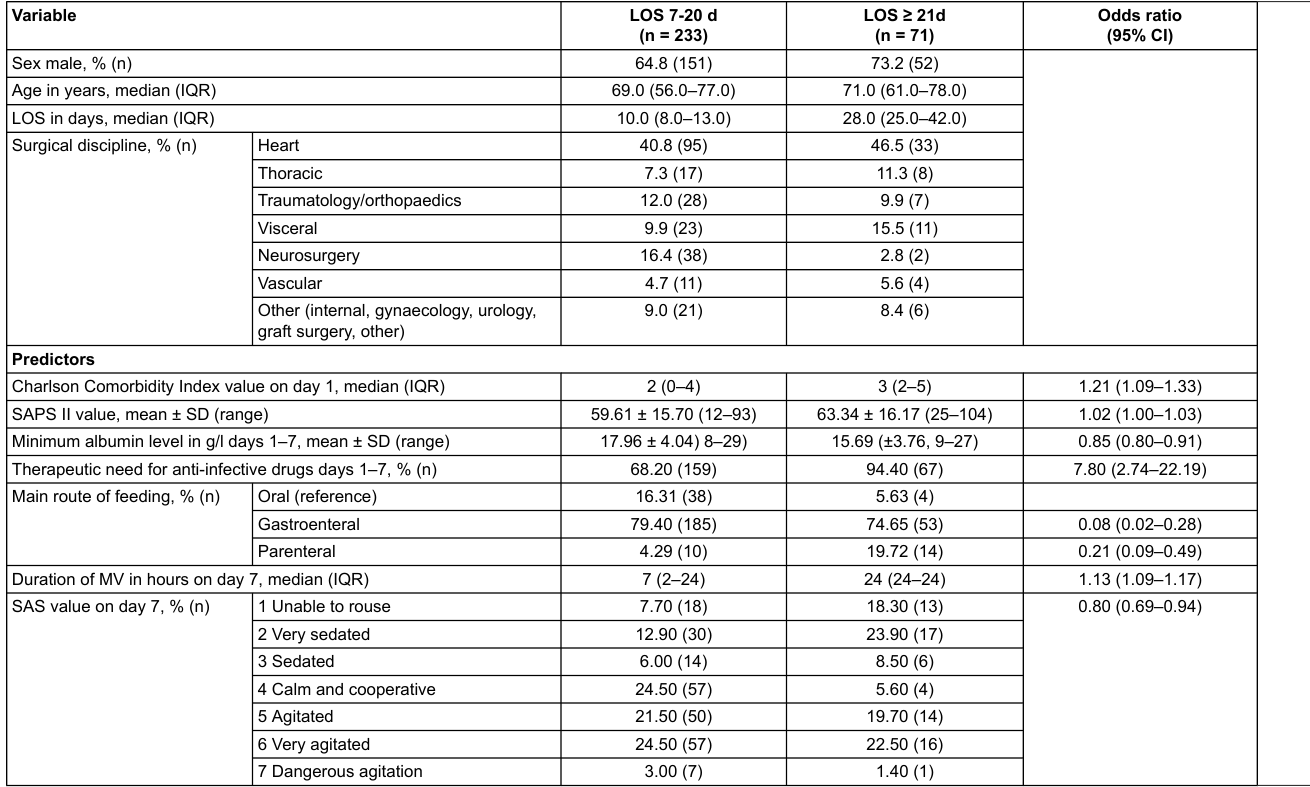
Table 2: Comparison of study variables in Group 1 (LOS 7–20 d, n = 233) and Group 2 (LOS ≥ 21 d, n = 71) in the development sample (n = 304)